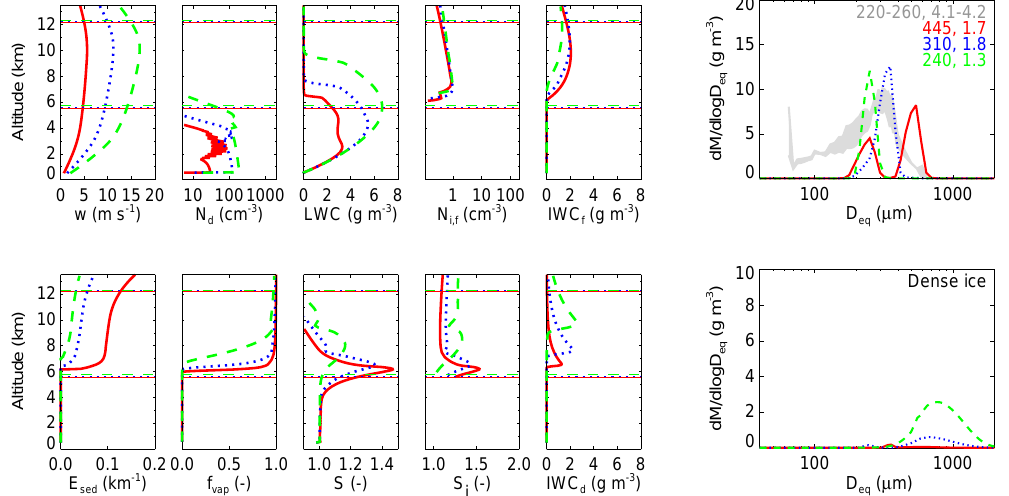
Figure 12. Panels and processes as in Fig. 10 with parcel depth (cid:49)z = 1km, pseudo-Hallett–Mossop source of 2stdcm − 3 , and baseline updraft strength scaled by factors of 0.5 (red solid line), 1.0 (blue dotted line), and 1.5 (green dashed